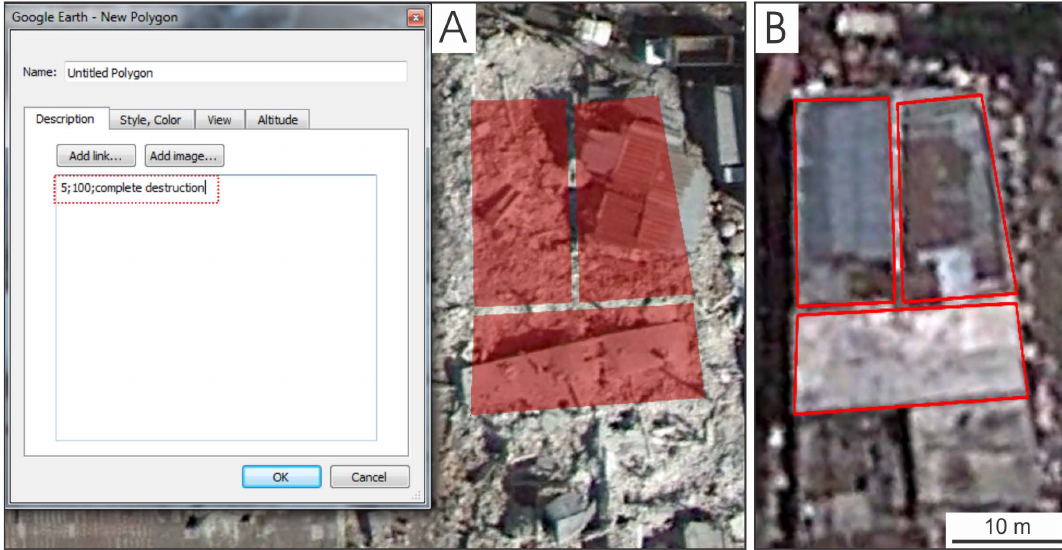
Fig. 6. Delineation of damaged buildings in Google Earth, and creation of kmz (Keyhole Markup Language) files that were later integrated by GEO-CAN. Identification of individual buildings, especially those with severe damage, is nearly impossible in post-event data alone (A) ; reference imagery (B) is needed. Volunteer mappers had to specify the damage level from 1 to 5 according to EMS98, confidence in the given score (in percent), and a comment such as on the damage level (dashed box). Screen captures from Google Earth. ©Google